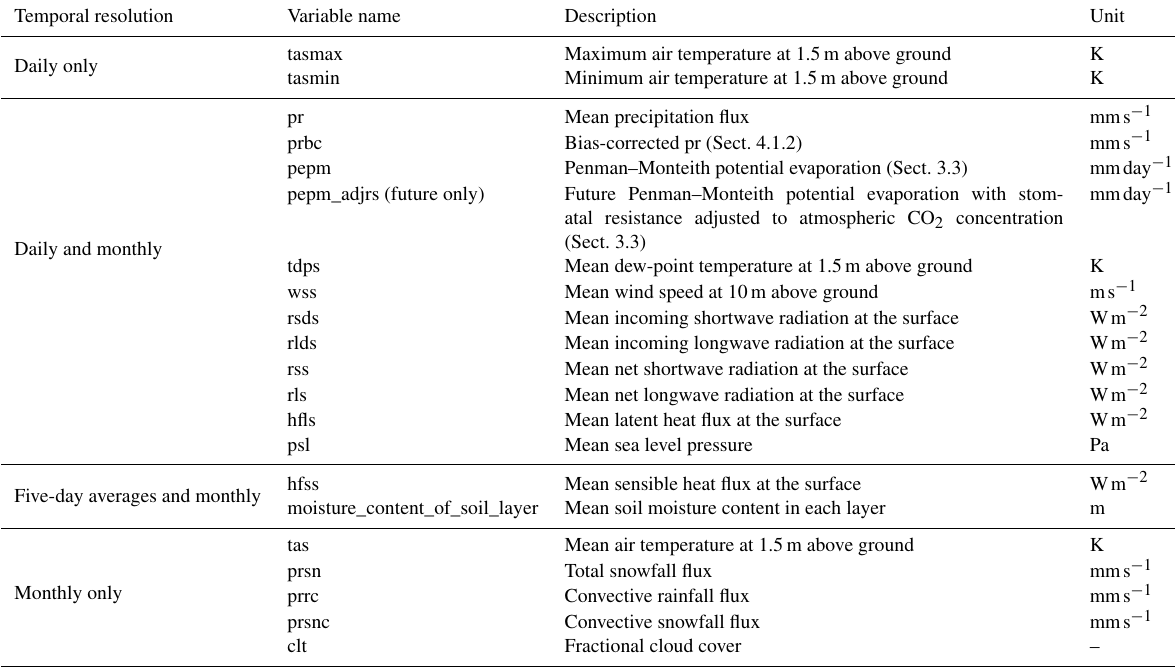
Table 3. Output variables available in the dataset at various temporal frequencies.